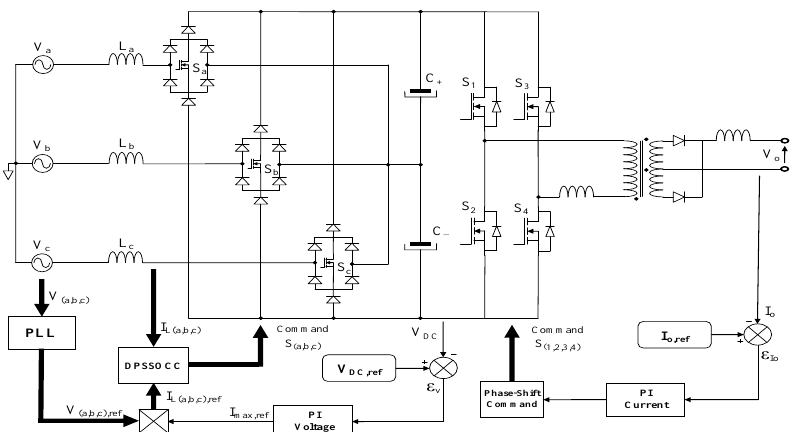
Figure 1. Circuit schematic of the complete energy conversion chain of a welding power source.